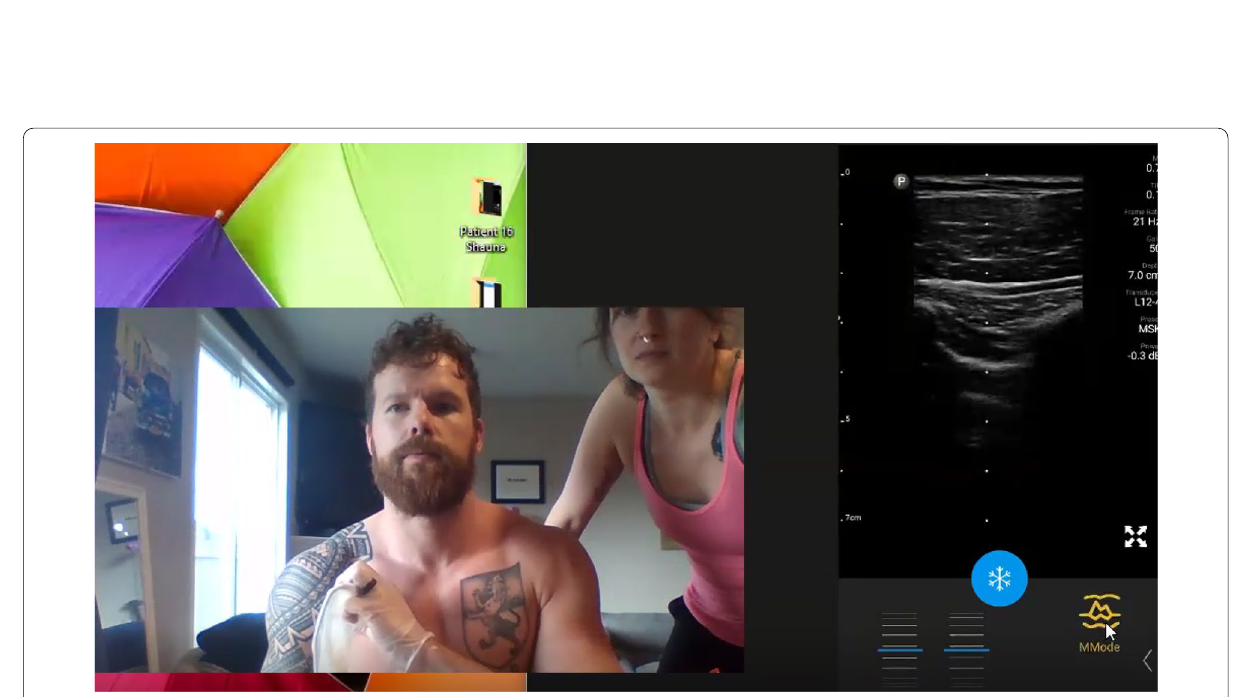
Fig. 2 Representative still image of mentee self-performing lung ultrasound to demonstrate the pleural interface. Ultrasound Naïve participant being instructed to demonstrate the pleural interface of the visceral and parietal pleural illustrating the “Batwing” sign of Lichtenstein [20]. It should be noted that all lung ultrasound is a dynamic examination better viewed real time and in video recordings (Additional file 4) than still